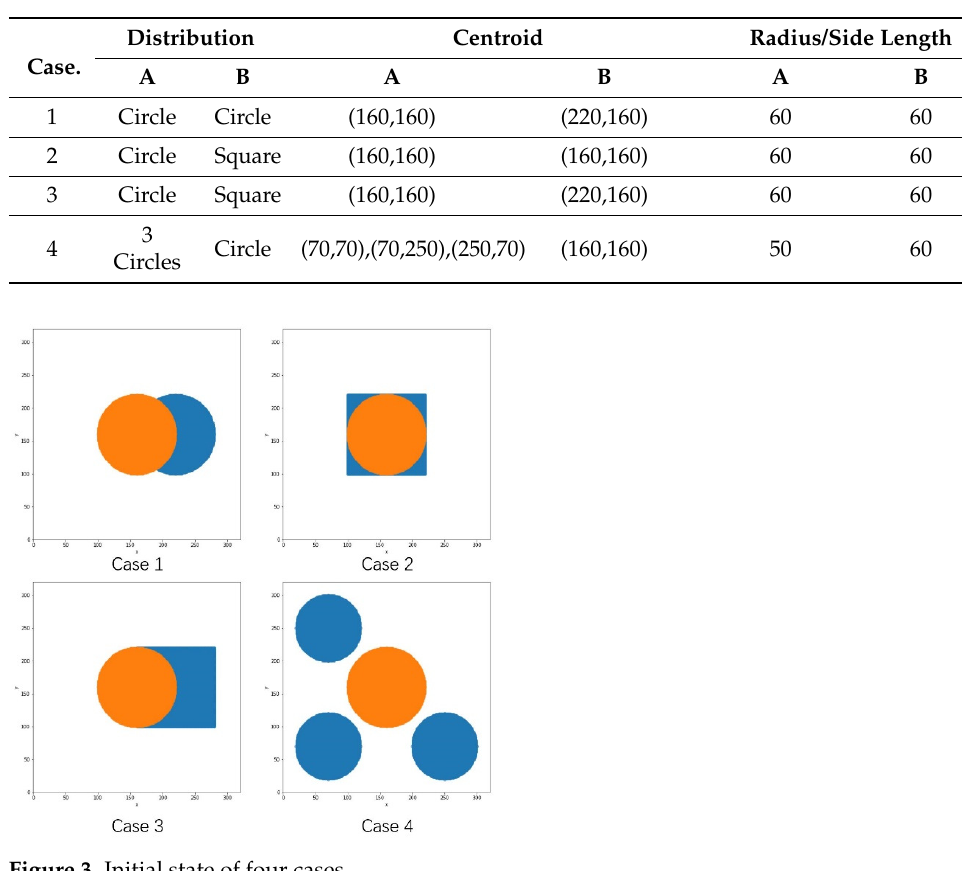
Figure 3. Initial state of four cases.